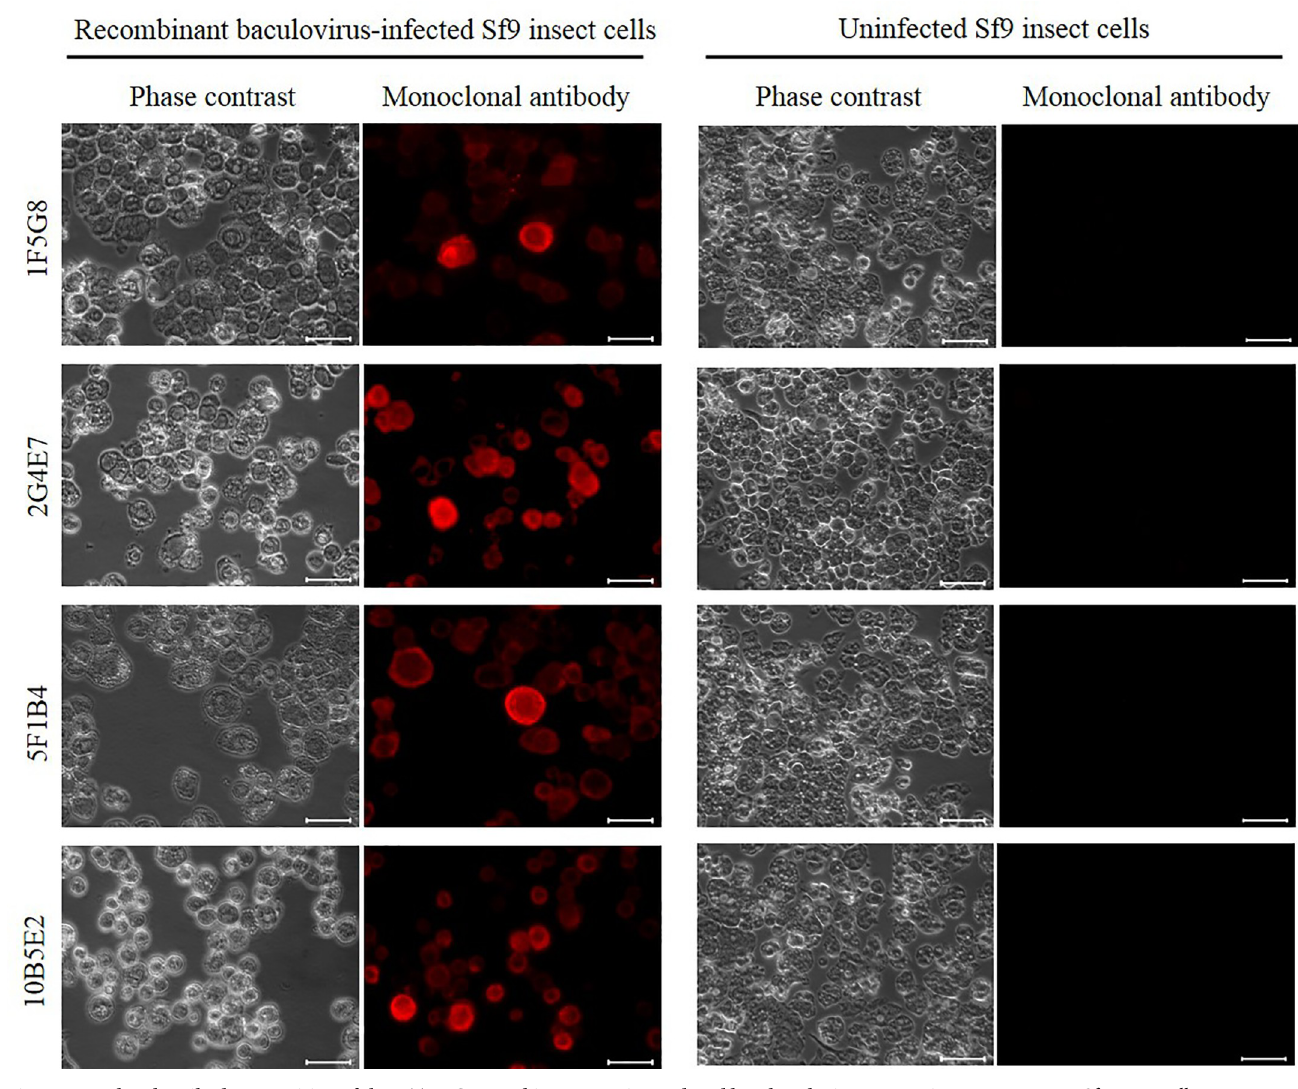
Fig 3. Monoclonal antibody recognition of the ILTV gG recombinant protein produced by a baculovirus expression vector system. Sf9 insect cells were infected with recombinant baculovirus and fixed at 72 h after infection. Immunofluorescence was performed with each anti-gG monoclonal antibody and with goat anti-mouse IgG antibody conjugated to Alexa Fluor 594. Red fluorescence corresponds to the binding of monoclonal antibodies to recombinant gG. Uninfected Sf9 cells were used as negative controls. Scale bars: 50 μ m. Image magnification: 400x.